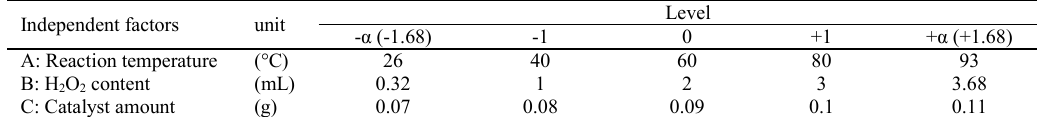
Table 1. The actual and code levels of independent factors.